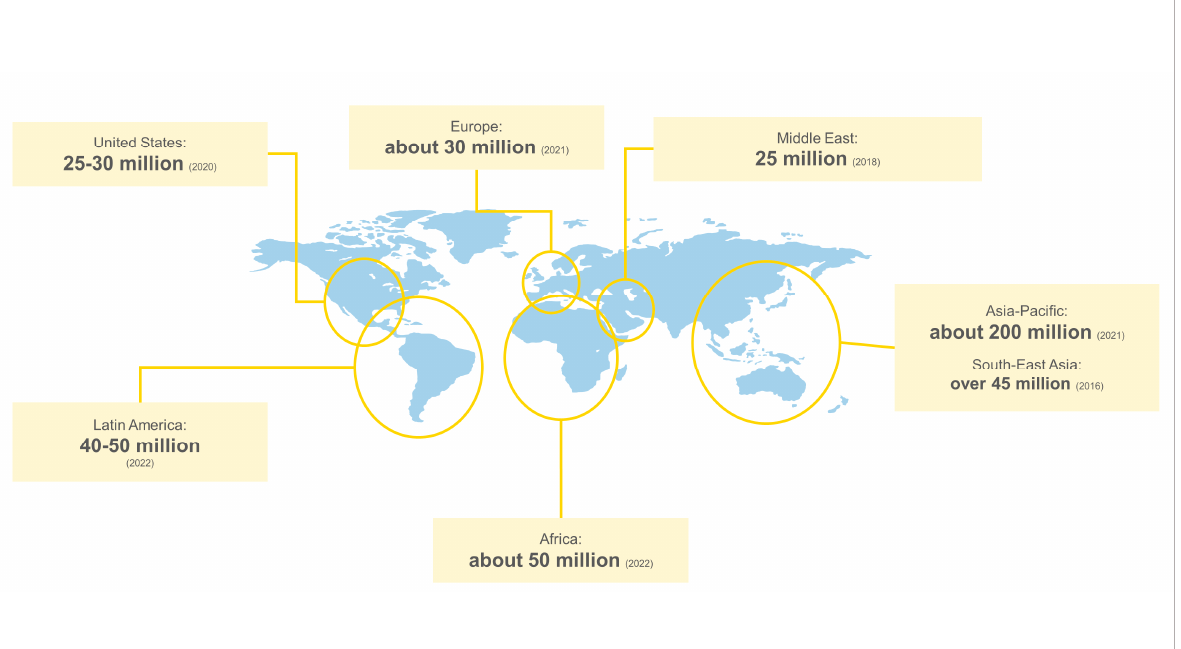
Figure 1. Number of people affected by RDs across regions. Source: Elaborated by authors based on overviewed literature [26–34]. The estimated values depend on data availability and local diagnostic and tracking capacity.